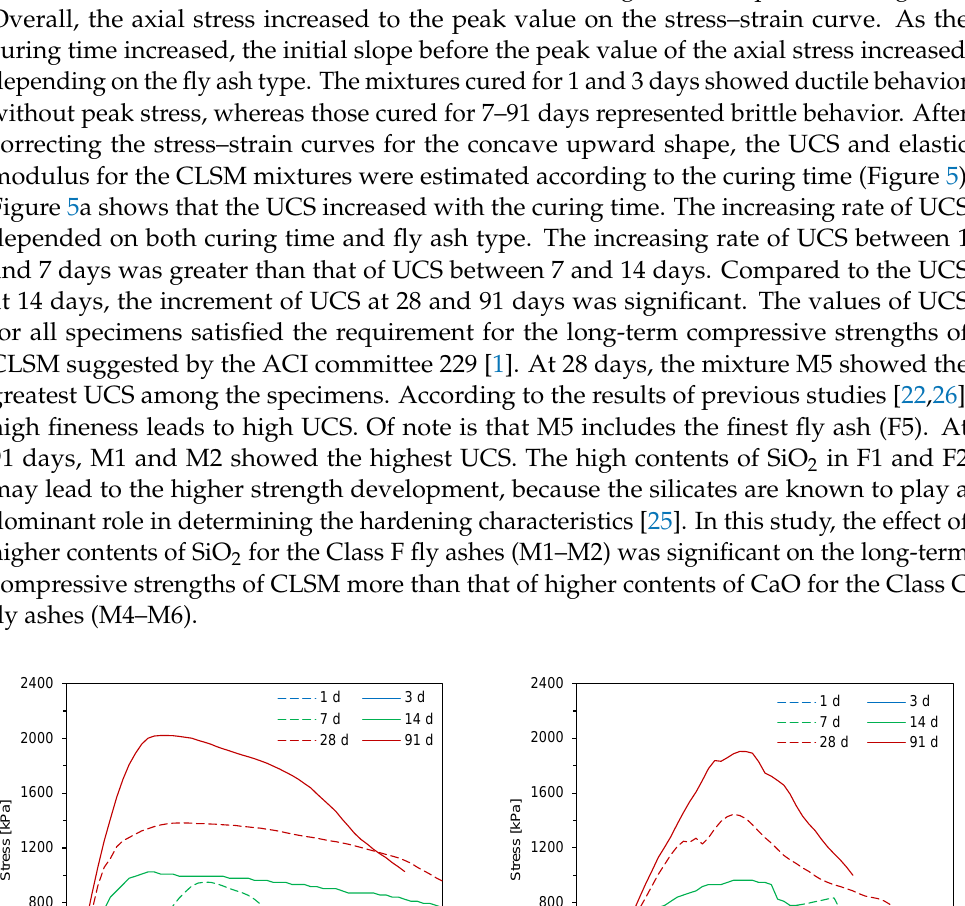
Figure 5. Results of unconfined compressive strength tests along curing time in different CLSM mixtures—( a ) unconfined compressive strength; ( b ) elastic modulus.